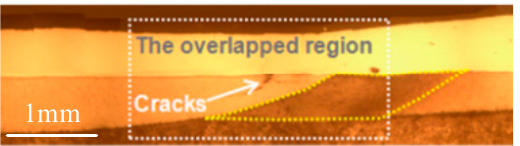
Figure 7. Cross-section macrographs of the two-layer Ni-based alloy cladding tracks on U71Mn rail by laser cladding (Reprinted from Ref. [26], copyright (2019), with permission from Elsevier). by laser cladding (Reprinted from ref. [26], copyright (2019), with permission from